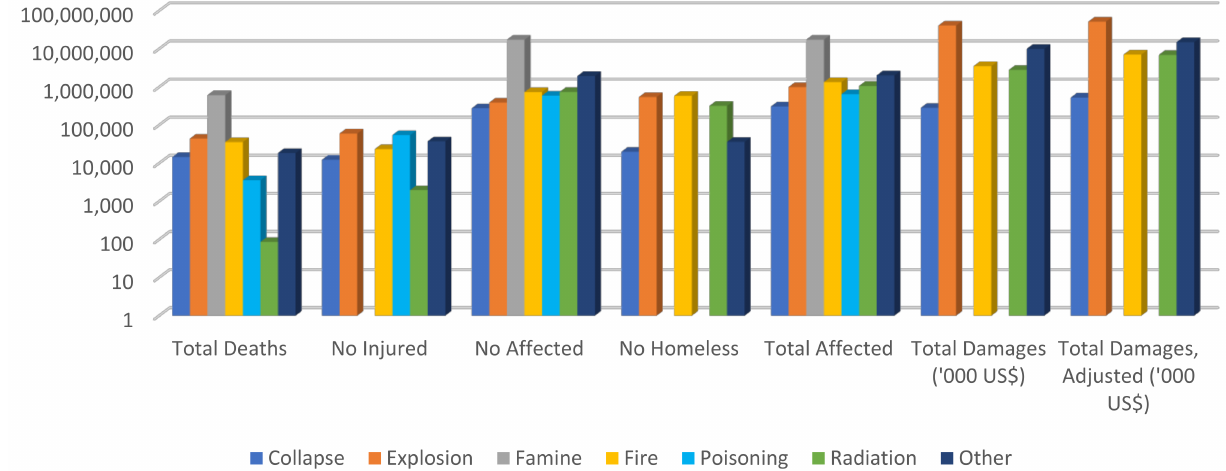
Figure 5. Comparative structure according to disaster subtype for period of 1900–June 2022 (source: authors’ work based on EM-DAT CRED database [18]).